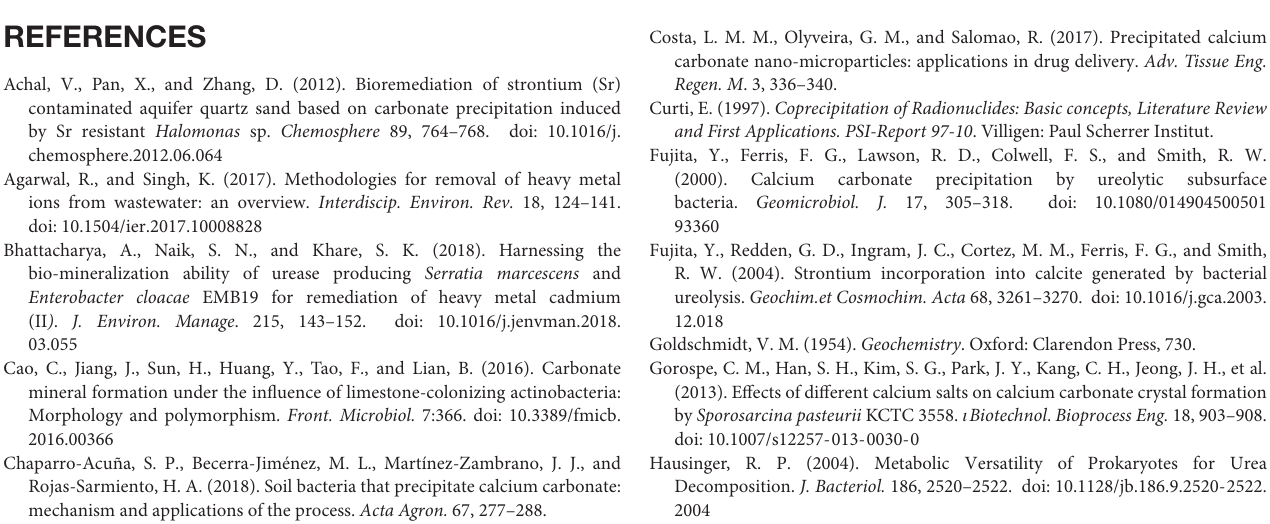
Supplementary Figure 1 | Scanning electron microscopy image of calcium carbonate precipitated at a range of copper concentrations: Cu, 0.1 mM (A) ; and Cu, 1 mM (B). Supplementary Figure 2 | Scanning electron microscopy image of calcium carbonate precipitated at a range of zinc concentrations: Zn, 0.01 mM (A) ; and Zn, 0.5 mM (B). Supplementary Figure 3 | Scanning electron microscopy image of calcium carbonate precipitated at a range of lead concentrations: Pb, 0.01 mM (A) ; and Pb, 0.1 mM (B). Supplementary Figure 4 | Scanning electron microscopy image of calcium carbonate precipitated at a range of cadmium concentrations: Cd, 0.01 mM (A) ; and Cd, 1 mM (B). Supplementary Figure 5 | Scanning electron microscopy image of calcium carbonate precipitated at a range of strontium concentrations: Sr, 1 mM (A) ; and Sr, 10 mM